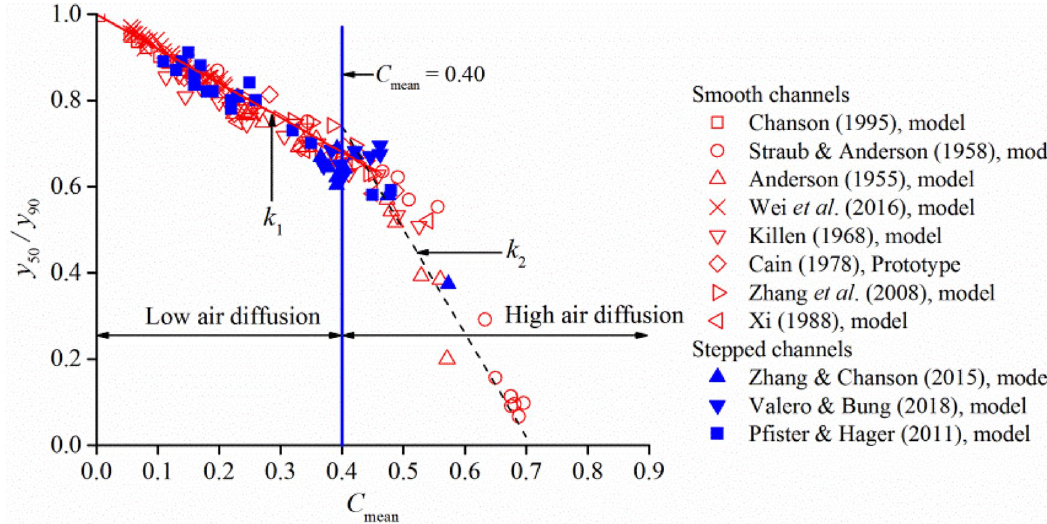
Figure 3. The variation of y 50 / y 90 with the increase of C mean in self-aerated open channel flows.